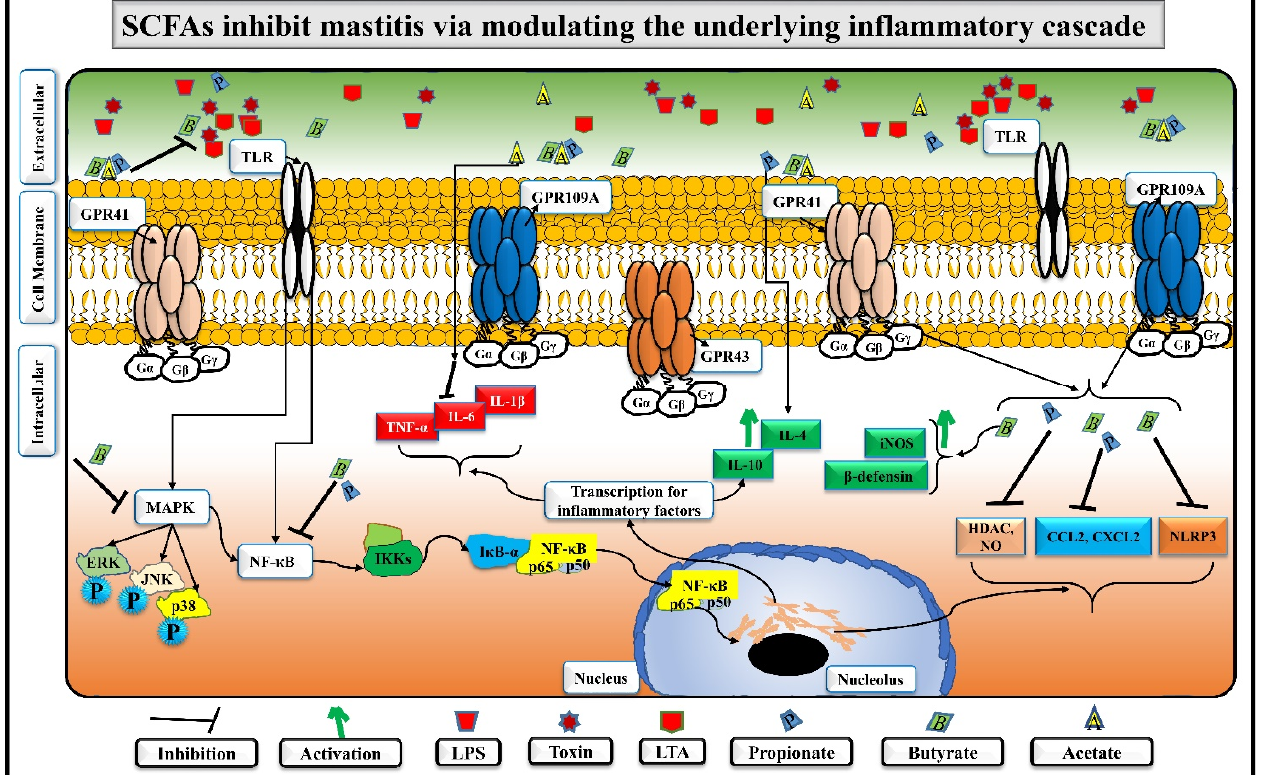
Figure 4. The extracellular and intracellular proposed mechanism of SCFAs inhibiting MAPKs/NF- κ B inflammatory cascade.